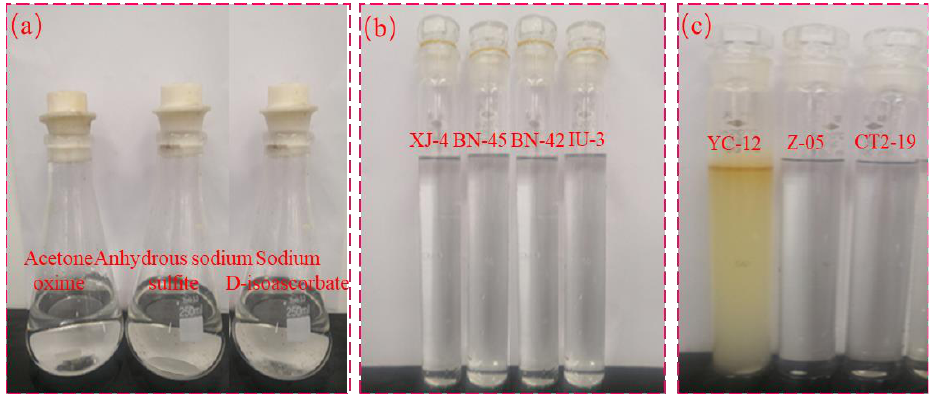
Figure 4. Compatibility of injected water with additives ( a ) deoxidizer; ( b ) bactericide; ( c ) corrosion inhibitor.